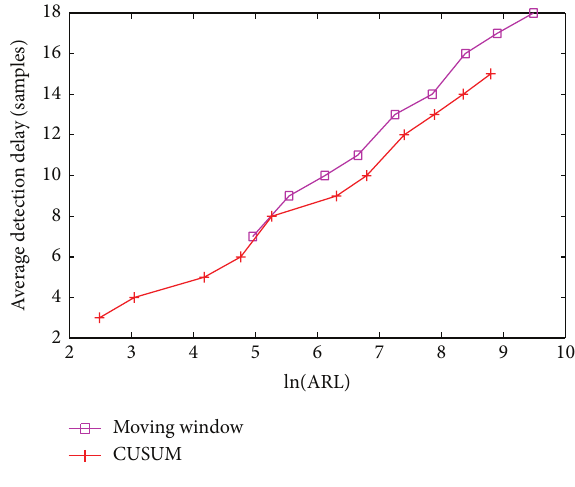
Figure 5: Average detection delay versus ln (ARL). Table 2: Slope of the curves in Figure